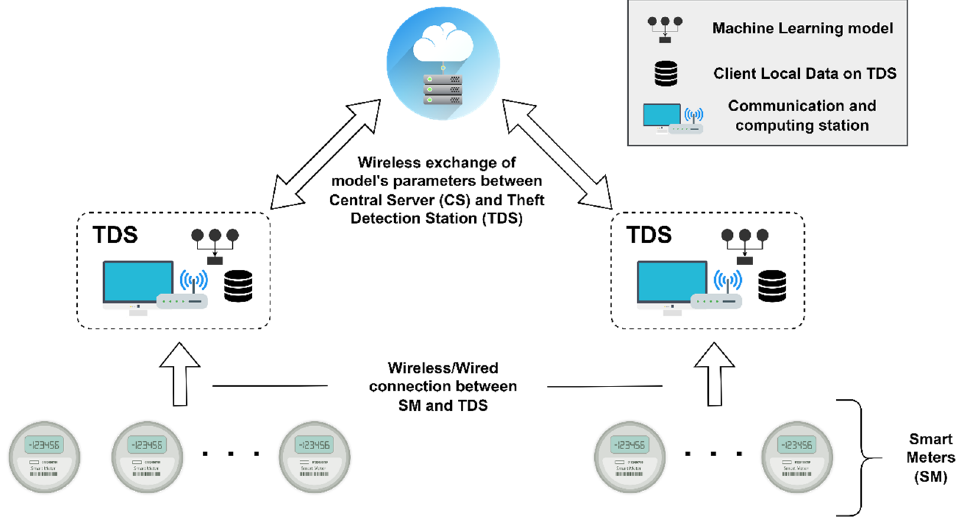
Figure 1. Federated learning enables smart grids networks for theft detection.